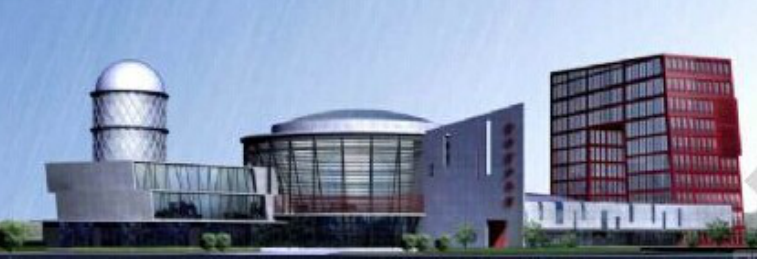
Figure 3: 3D model for the Children's Palace.